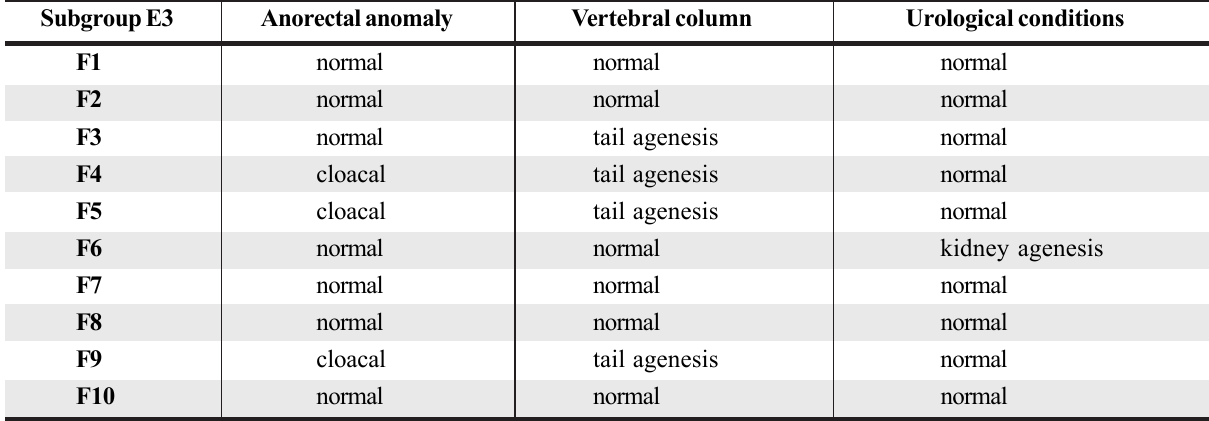
TABLE 7 - Associations between anomalies for the fetuses in subgroup E3